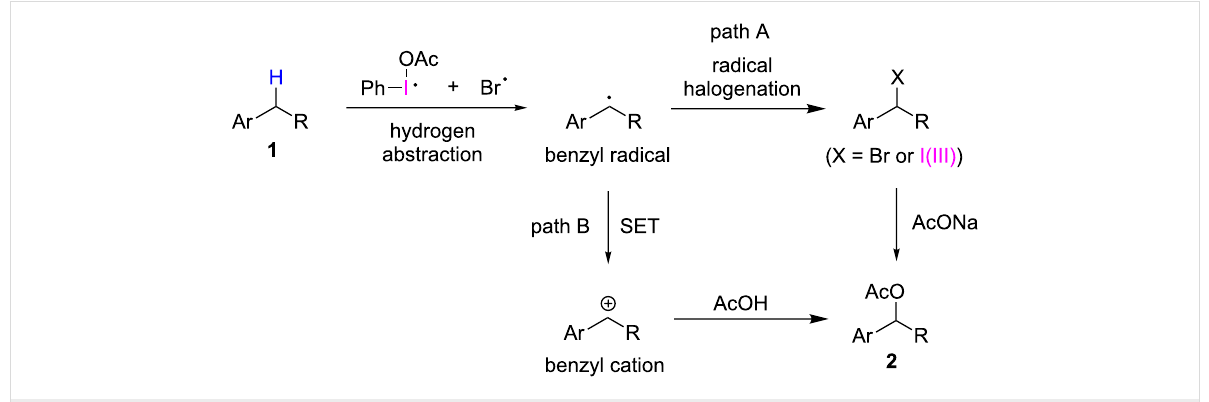
Scheme 4: Outline of the proposed reaction mechanism for the PIDA/NaBr